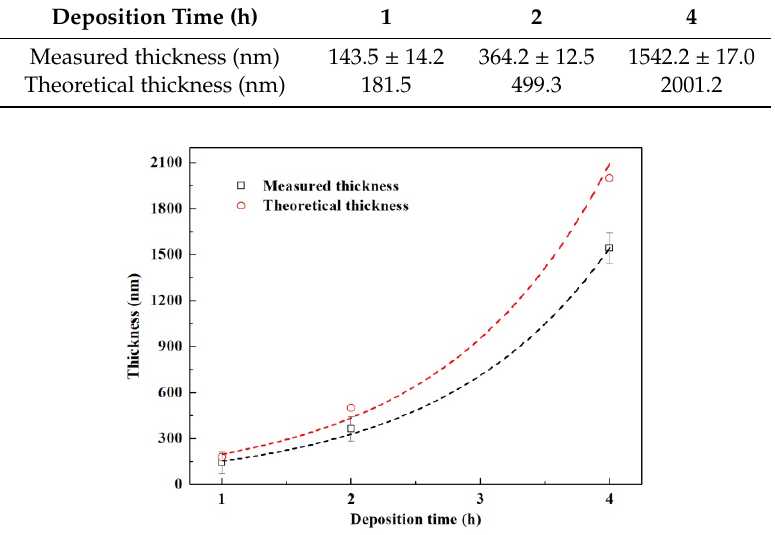
Figure 6. Cross-sectional morphology of the coatings deposited for: ( a ) 1 h, ( b ) 2 h and ( c ) 4 h. Table 1. Measured thickness and theoretical thickness of the coatings.